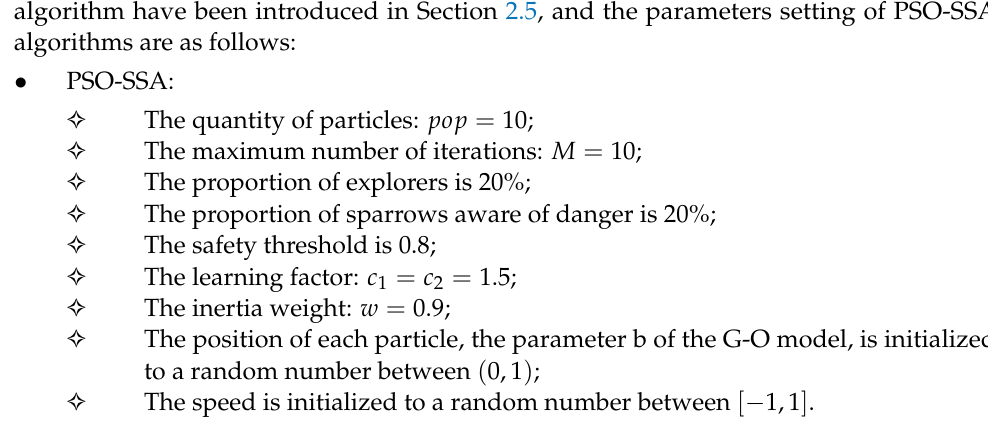
Figure 19. Actual and estimated results of two algorithms (SS3). Figure 20. Actual and estimated results of two algorithms (CSR1).